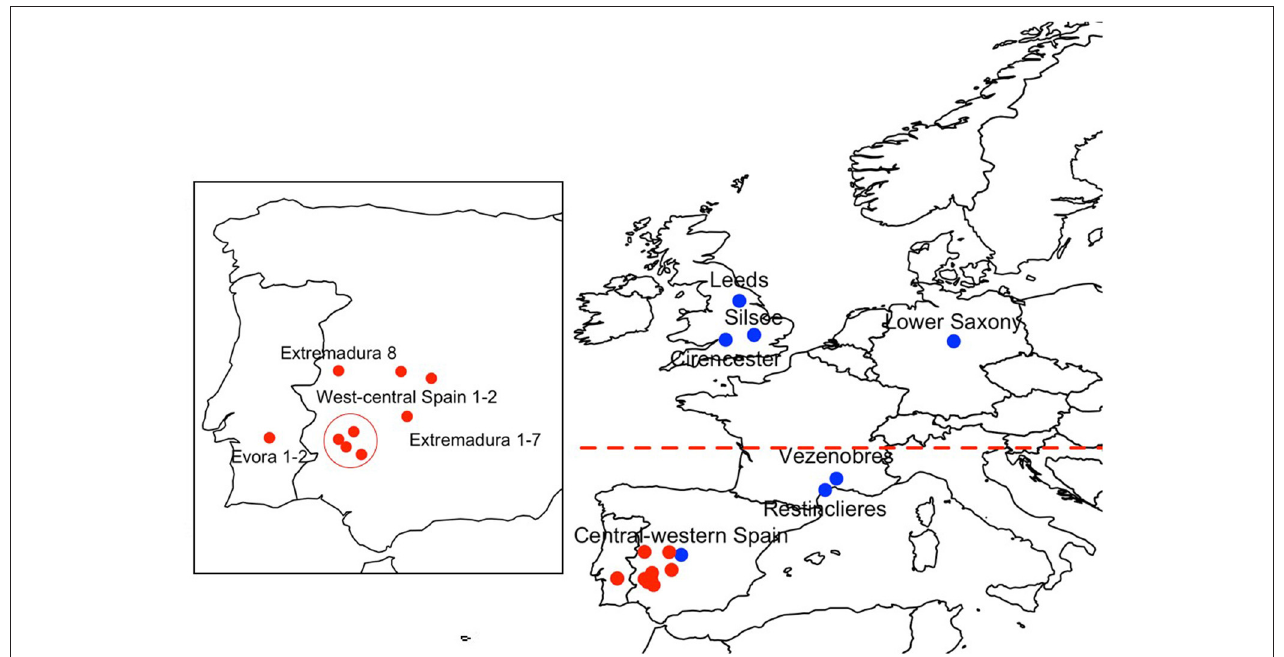
FIGURE 2 | Map of experimental sites. Alley cropping sites are shown with solid blue circles ( • ), while Dehesa sites are shown with solid red circles ( • ). A horizontal line at 45 degrees latitude separates “northern” from “southern” sites. Inset shows the Iberian peninsula enlarged to show locations of sites in the Extremadura (1–8), West-central Spain (1–2), and Evora (1–2). Multiple sites in the same region were identified by number, e.g., 1–8 in Extremadura. See Table 1 for further information on